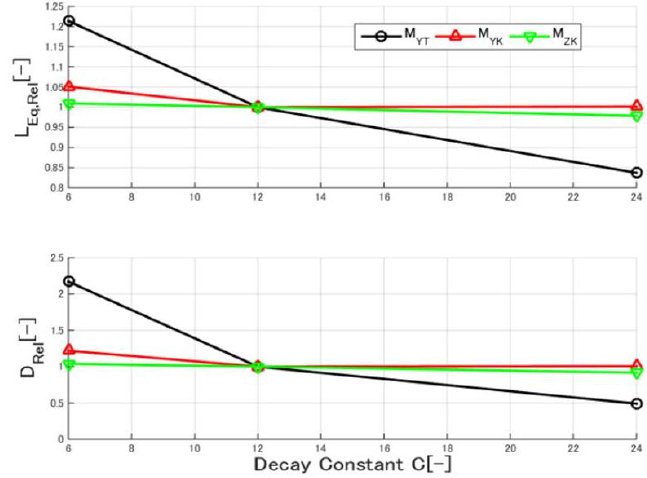
Figure 15. Damage equivalent load (DEL) and relative fatigue damage (8.5 m/s of annual average wind speed, m = 4).